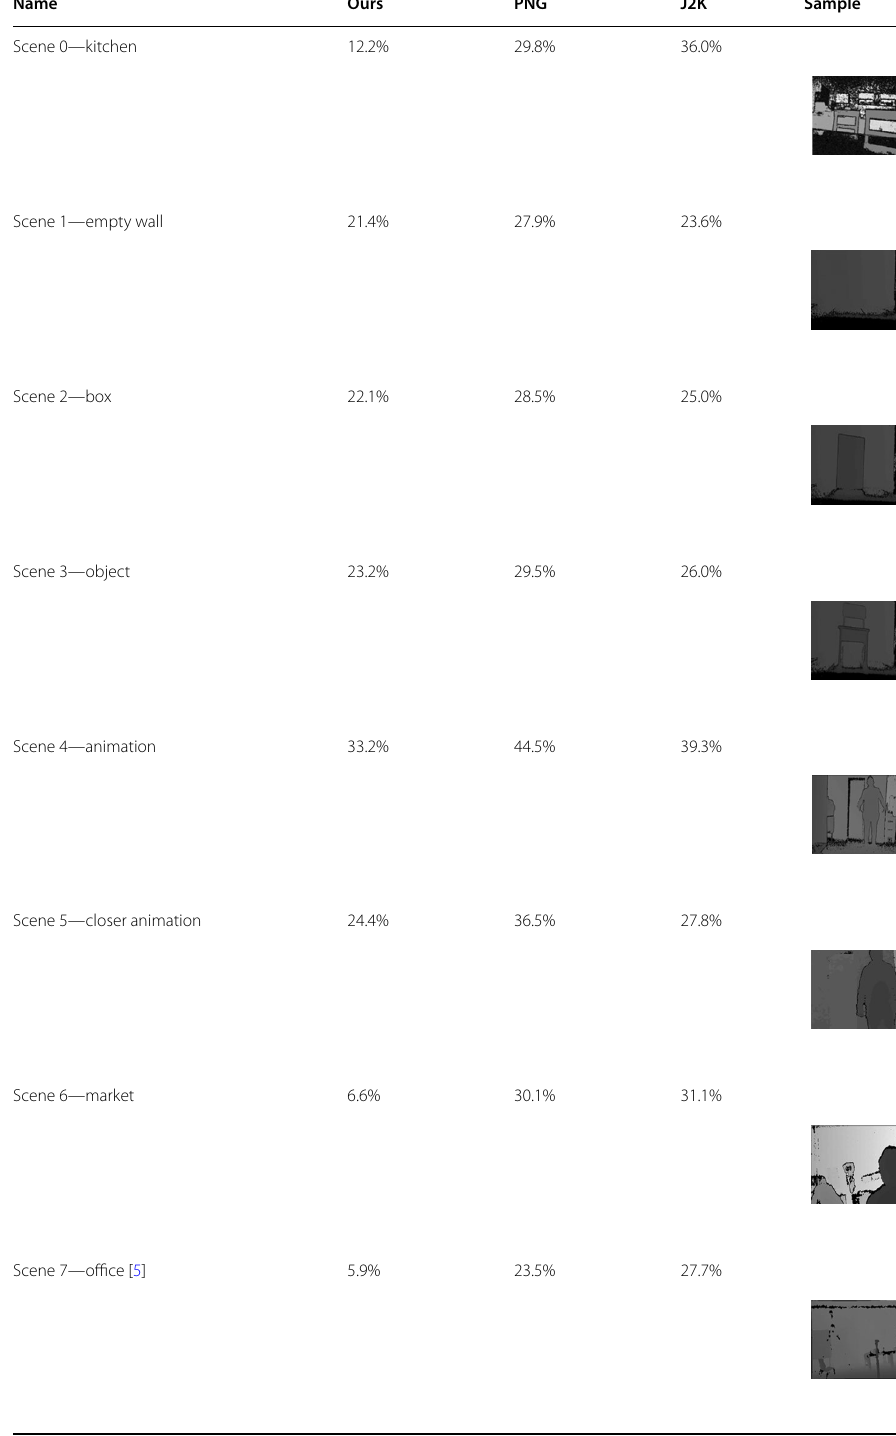
Table 1 Lossless compression